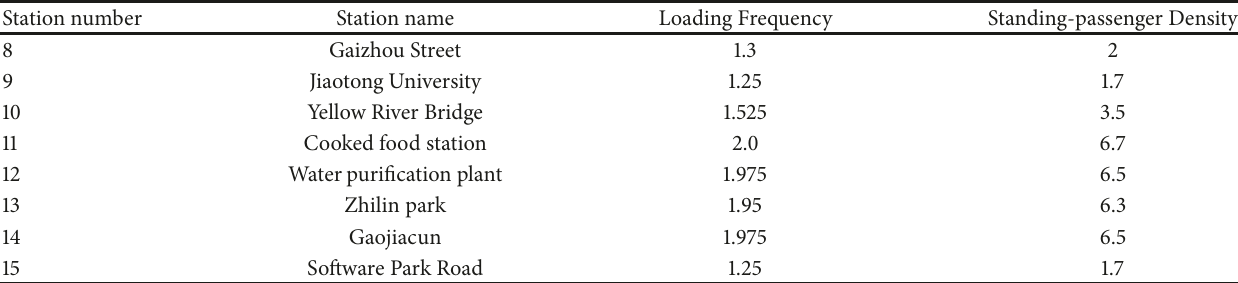
Table 10: The load factor and standing-passenger density corresponding to the predicted number of people.